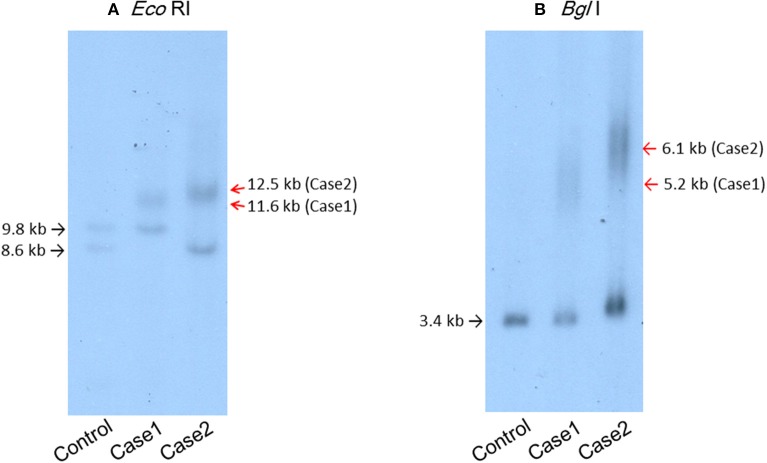
Southern blot analysis of the patients' genomic DNA samples digested with EcoRI (A) or BglI (B) and then probed with the BamHI fragment containing the DMPK CTG repeat region. (A) Lane 1, genomic DNA from a control individual with an EcoRI polymorphism (10) in one allele. Lane 2, case 1. Lane 3, case 2.